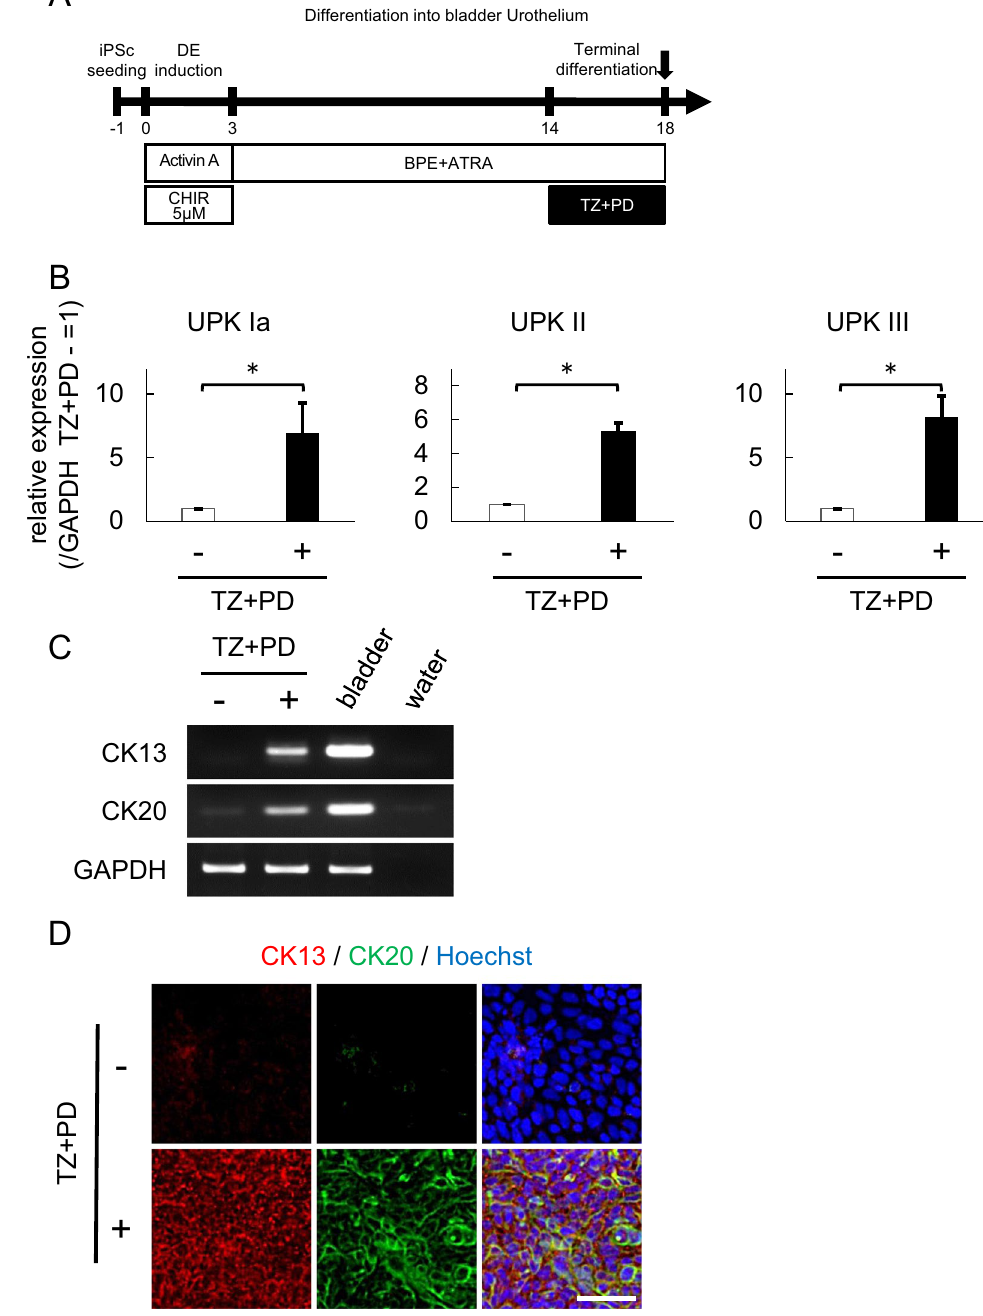
Figure 3. A PPAR- γ agonist and an EGFR inhibitor enhanced the terminal transitional differentiation into bladder urothelium. ( A ) A schematic diagram shows that the PPAR- γ agonist Troglitazone (TZ) and EGFR inhibitor PD153035 (PD) were added for the last four days to complete terminal transitional differentiation into bladder urothelium. ( B ) A qPCR analysis of the urothelial markers UPK Ia, UPK II, and UPK III after TZ + PD treatment for 4 days to complete terminal differentiation (n = 5 independent experiments; mean ± SEM, * p < 0.05; two-tailed paired t test). ( C ) An expression analysis of the transitional differentiation markers CK13 and CK20 at day 18 by semi-quantitative RT-PCR. Bladder RNA was used as a positive control. Full-length gels are presented in Supplementary Figure 6. ( D ) Immunostaining of CK13 and CK20 in differentiated cells after treatment with (lower panels) or without (upper panels) TZ + PD for 4 days. Representative fluorescence microscopic images are shown. Scale bar, 50 μ m. Abbreviations: iPSc, induced pluripotent stem cell; DE, definitive endoderm; CHIR, CHIR99021; BPE, bovine pituitary extract; ATRA, all-trans retinoic acid; TZ, troglitazone; PD, PD153035; UPK,